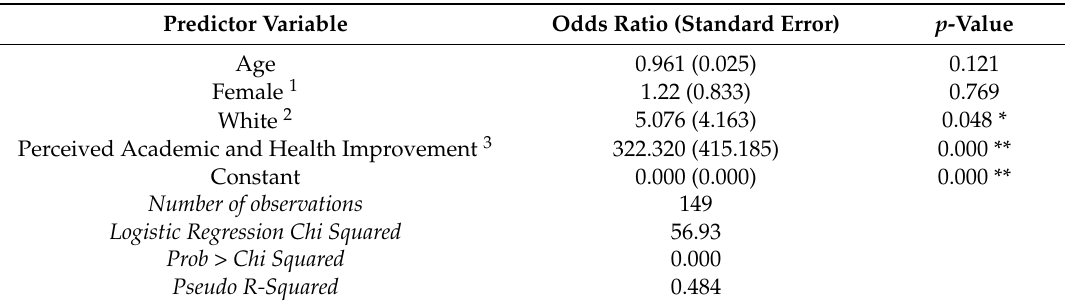
Table 6. Model 2: Logistic regression model to predict instructor favorability of introducing standing desks in college